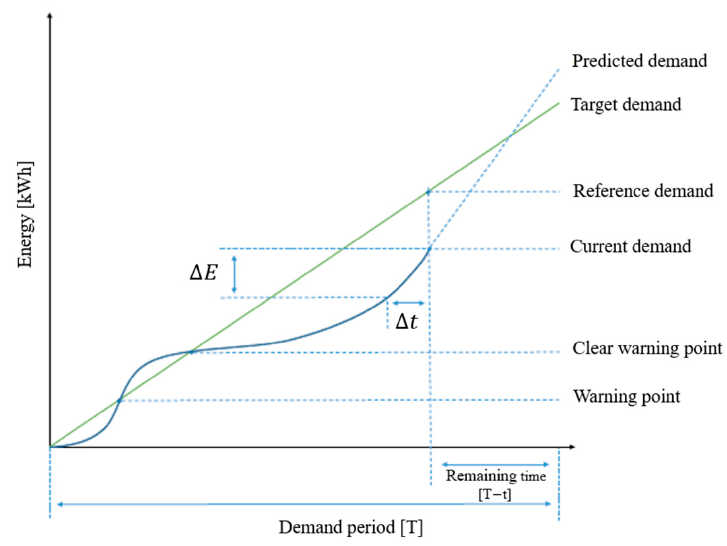
Figure 3. Principal of the maximum demand control.